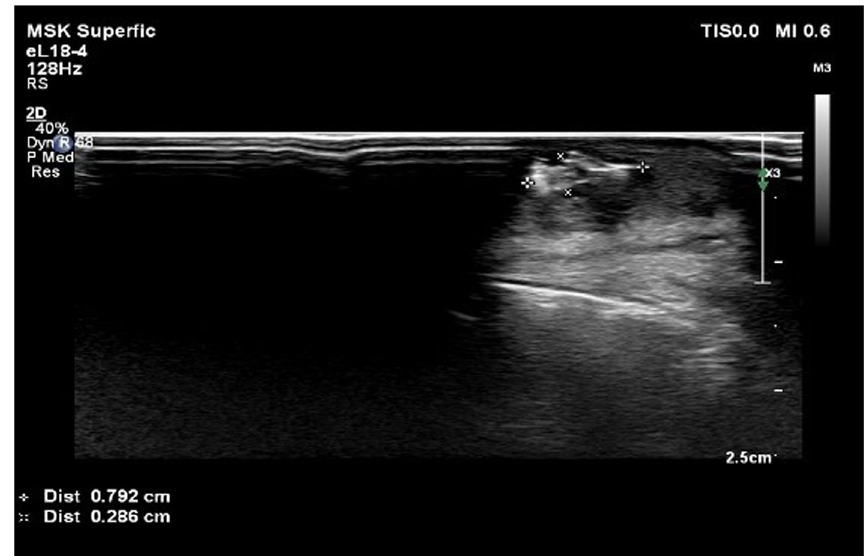
Fig. 2 USG upper lip—7 mm echogenic